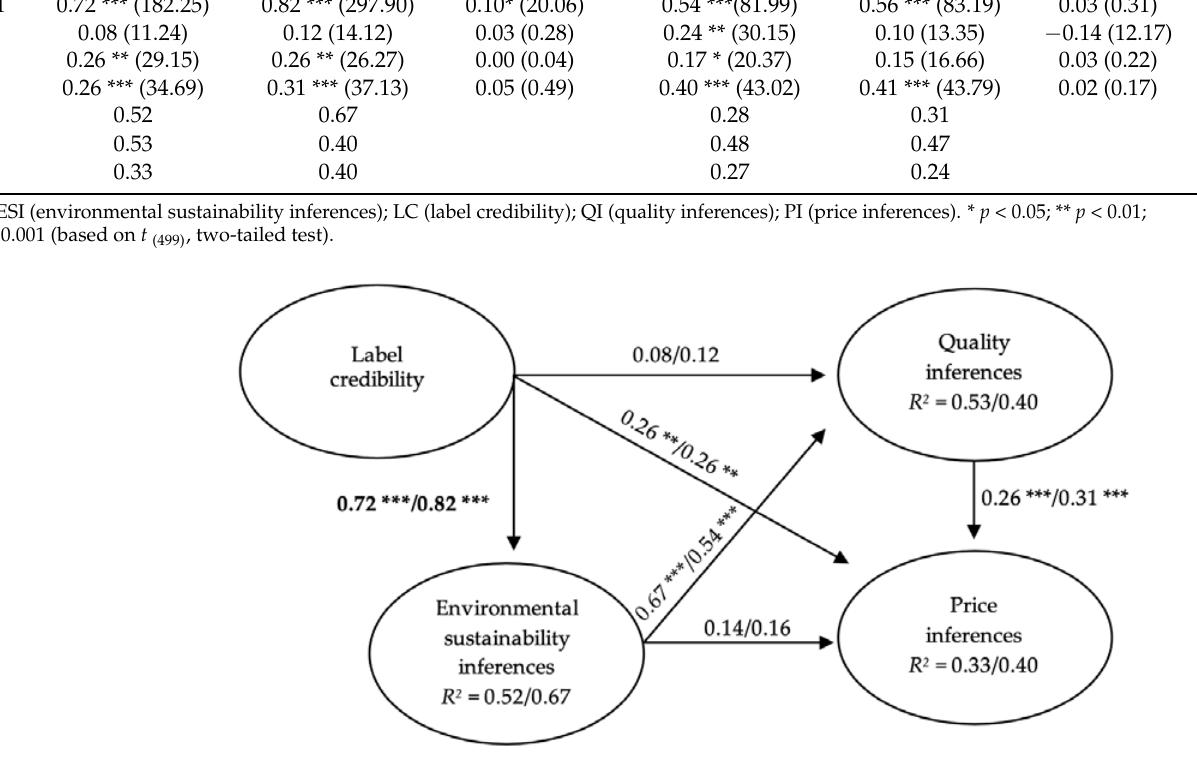
Table 3. Multigroup comparison.